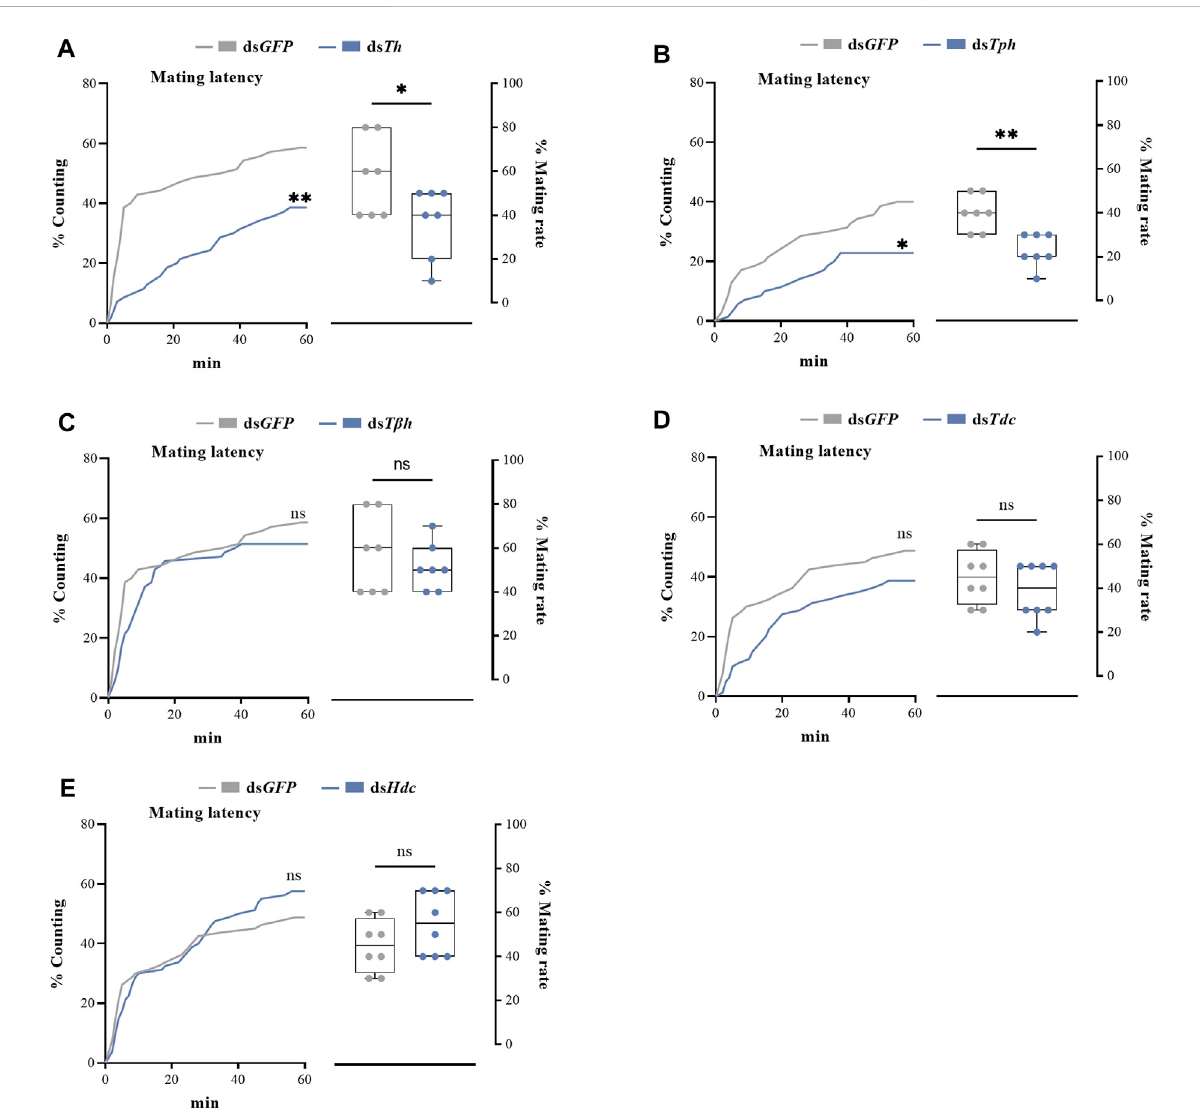
FIGURE 3 Therolesofgenescodingforbiosynthetic enzymesofbiogenicamines,including Th (A) , Tph (B) , T β h (C) , Tdc (D) and Hdc (E) ,inmating latency (left) and mating rate (right) of B. dorsalis . Mating assays were performed at 72 h after the injection of dsRNAs in virginal male fl ies (13th day post emergence). Values are the means (± SEs) of replicates. Statistical comparisons were based on Log-rank (Mantel-Cox) test (mating latency) and Students ’ s t test (mating rate). The level of signi fi cance for the results was set at * p < 0.05, ** p < 0.01, *** p <